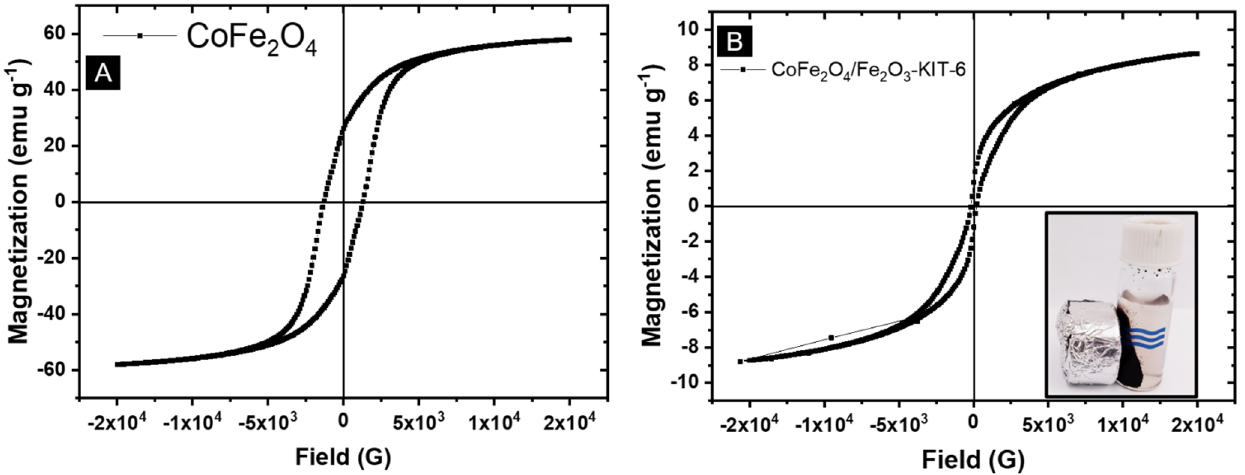
Figure 8. Magnetometry study: ( A ) Pure CoFe 2 O 4 ; ( B ) CoFe 2 O 4 /Fe 2 O 3 -KIT-6 solid. The inset shows the magnetic separation of the CoFe 2 O 4 /Fe 2 O 3 -KIT-6 catalyst.